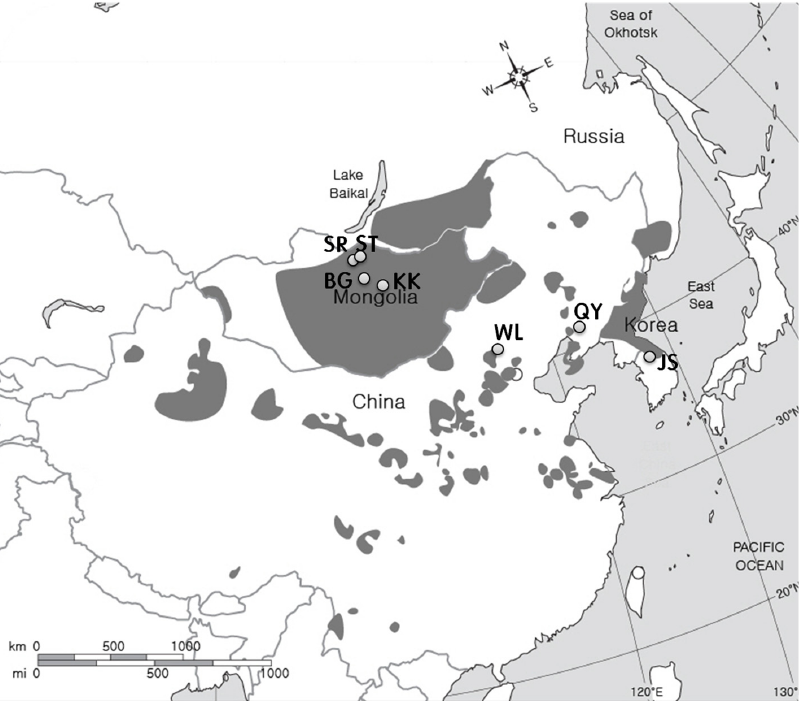
Figure 1. Natural distribution of the Siberian elm ( U. pumila L.) and locations of seven sampling sites in Mongolia (Bayan Gobi, BG; Khugnukhan, KK; Selenge Steppe, ST; Selenge River, SR), China (Qingyuan, QY; Wulanaodu, WL) and Korea (Jeongseon, JS).